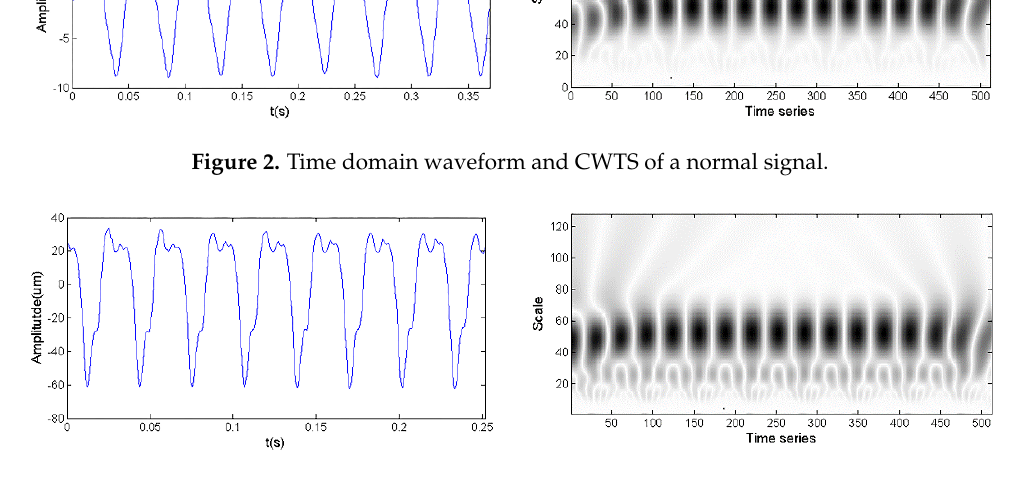
Figure 3. Time domain waveform and CWTS of a fault signal.